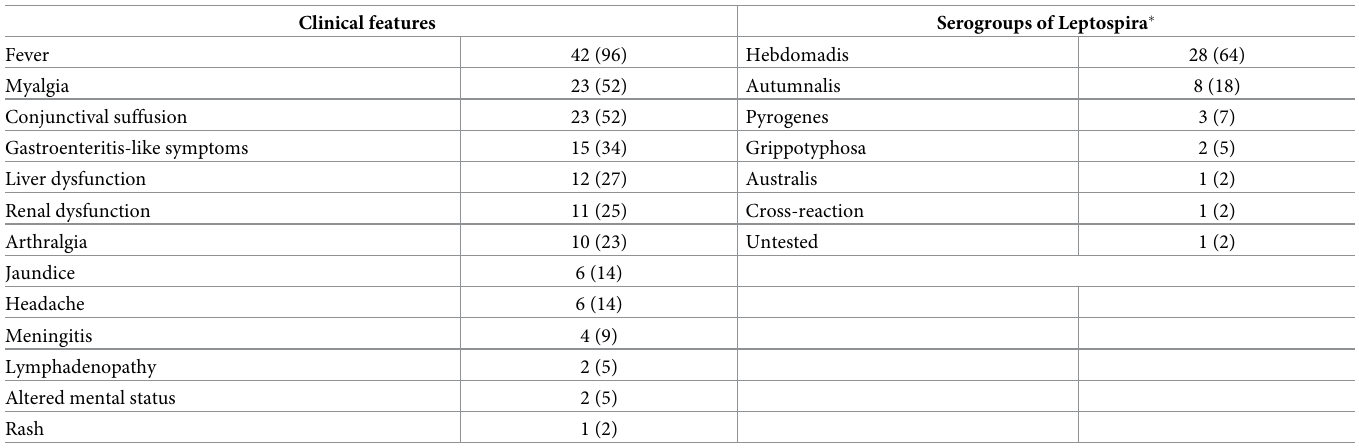
Table 2. Patient characteristics (n = 44), no.